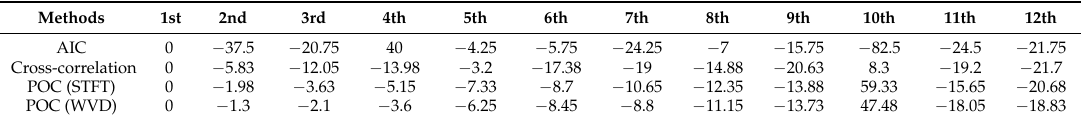
Figure 9. The POC function between the first trace and the 12th trace. Table 6. The estimated values of the relative arrival times of the first noisy dataset (signal-to-noise ratio (SNR) = 5 dB).